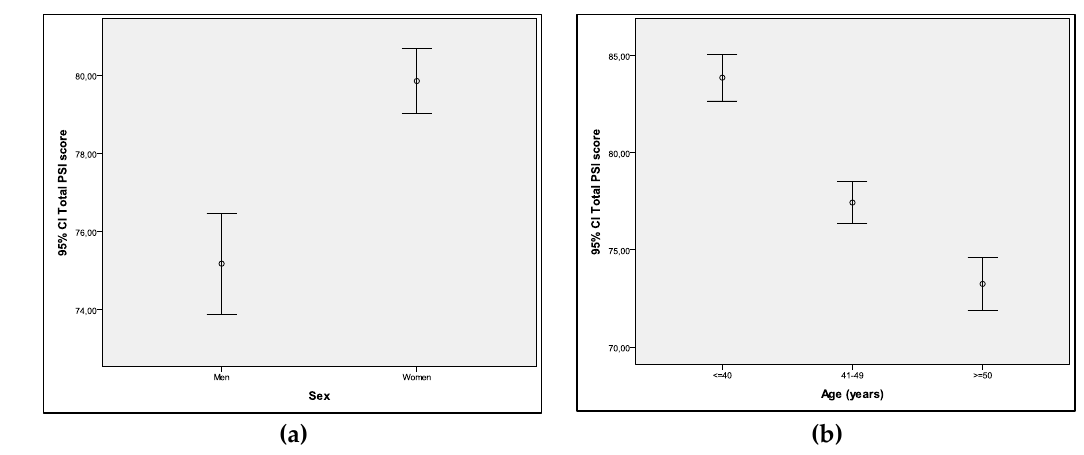
Figure 1. Error bars for Problem Solving Inventory (PSI) total score by (a) sex; and (b) age groups.